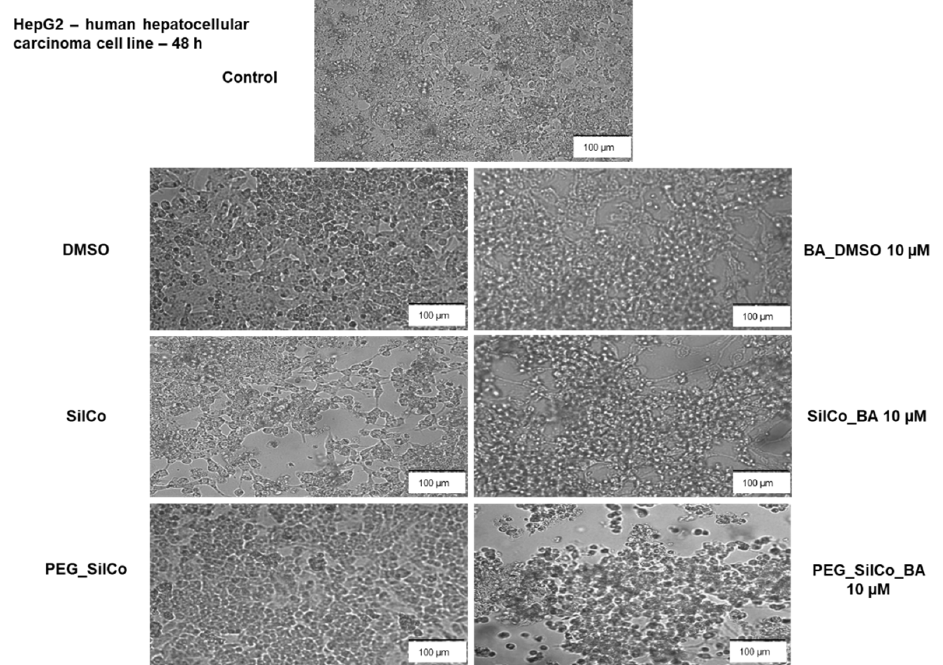
Figure 5. Microscopical appearance of HepG2 cells after a 48-h treatment with 10 µM of test com- pounds (BA_DMSO, SilCo_BA, PEG_SilCo_BA, SilCo, PEG_SilCo and DMSO). The pictures were taken at 48 h post-treatment under bright field light. Scale bar represents 100 µm.